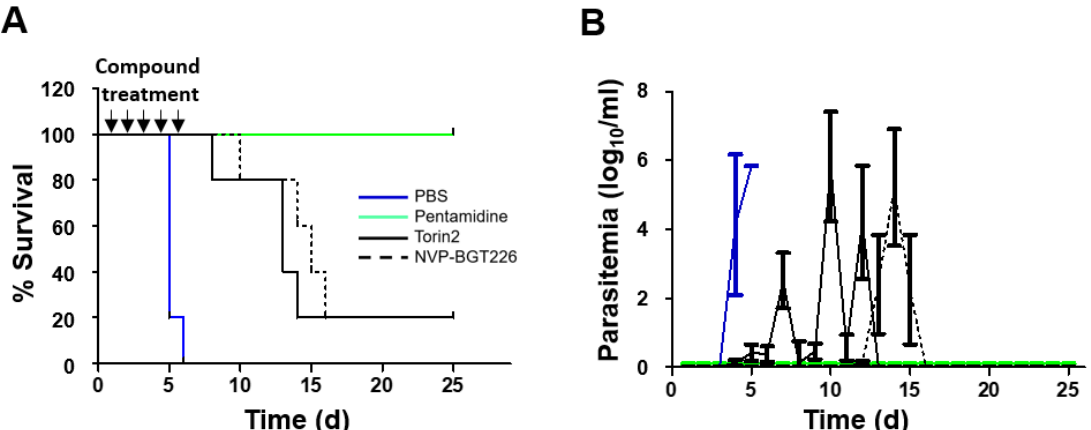
Figure 7. In vivo results for T. brucei mouse model of infection. ( A ) Mouse survival after treatment with 30 mg / kg pentamidine (solid green line), 15 mg / kg Torin2 (solid black line), 5 mg / kg NVP-BGT226 (dotted black line), or the PBS control (solid blue line) for 5 days. ( B ) Parasitemia as a function of time after treatment.